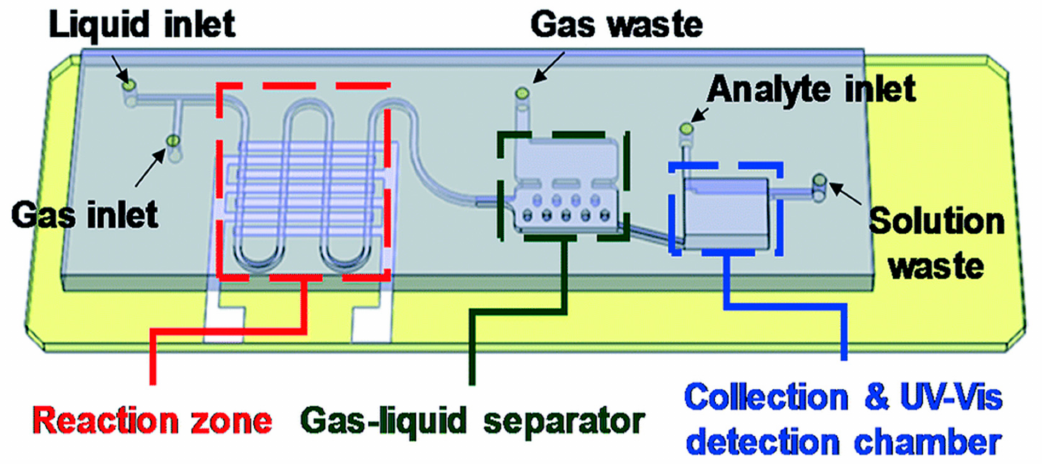
Figure 23. ( A ) Schematic representation of microfluidic system arrangements for microcapsule gener- ation. The continuous phase is shown in blue, while the discrete phase is in green. ( B ) 2D geometry of the droplet generation junction in the designed microfluidic system chosen by Campaña et al. (a) Continuous phase inlet of 2 mm, (b) dispersed phase inlet of 1 mm, (c) initial interface of 1 mm, (d) continuous phase inlet of 1 mm and (e) flow outlet of 2 mm. Reprinted from an open-access source [83].